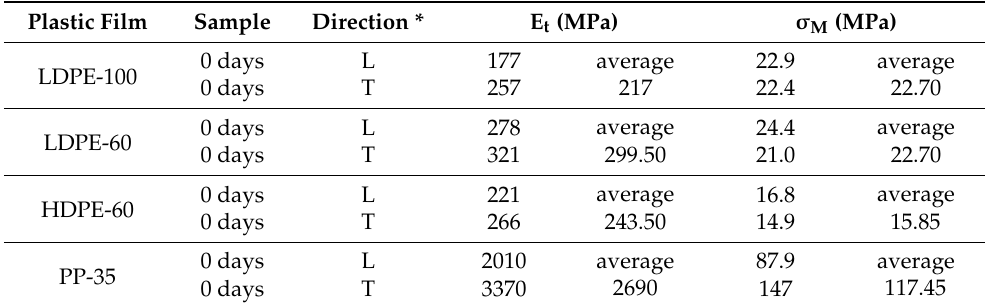
Table 6. Young’s modulus and maximum tensile strength data for 0 days samples and for longitudinal and transversal comparison.